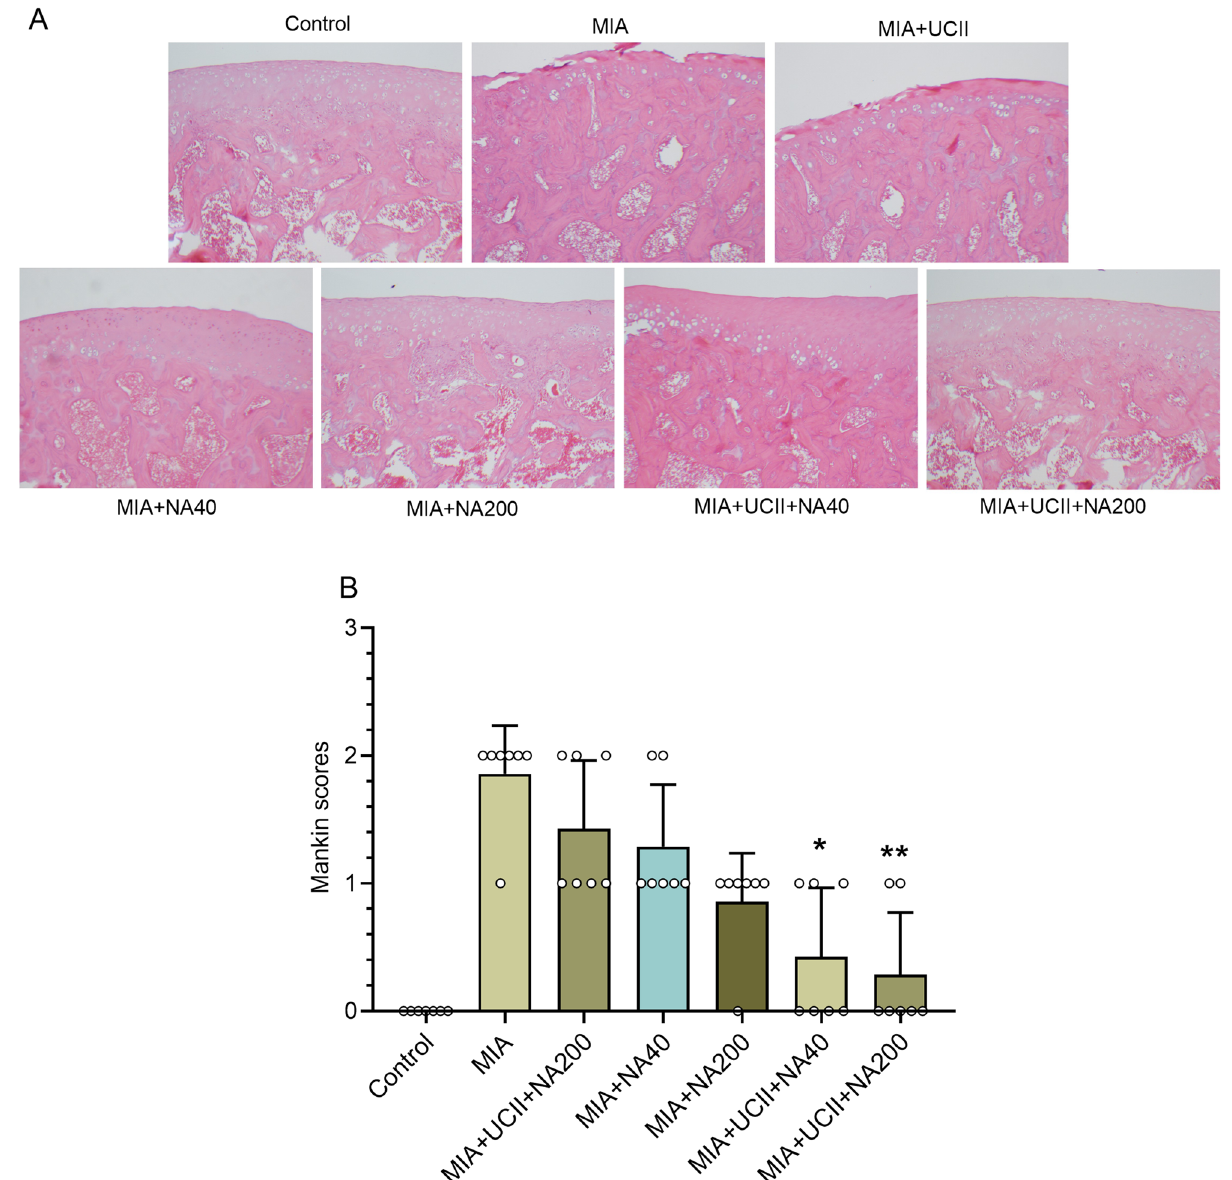
Figure 4. Effects of niacinamide (NA) and undenatured type II collagen (UCII) supplementation on histopathology of the knee joint in monosodium iodoacetate (MIA)-induced osteoarthritis in rats. Representative histopathologic images of hematoxylin–eosin (A) obtained at the end of the experiment are shown. Mean values of Mankin scores are demonstrated with ± standard deviations (B) . Asterisks above the groups indicate statistical differences (Kruskal–Wallis followed by Mann–Whitney U; * p < 0.05; ** p < 0.01; compared as MIA group). Control as a non-supplemental group with no osteoarthritis-induced rats, MIA as a non-supplemental group with monosodium iodoacetate (MIA)-induced knee osteoarthritis, MIA + UCII as MIA group gavage-fed a supplemental UCII at 4 mg/kg, MIA + NA40 as MIA group gavage-fed supplemental niacinamide (NA) at 40 mg/kg, MIA + NA200 as MIA group gavage-fed a supplemental NA at 200 mg/kg, MIA + UCII + NA40 as MIA group gavage-fed both supplemental UCII at 4 mg/kg and NA at 40 mg/kg and MIA + UCII + NA200 as MIA group gavage-fed both supplemental UCII at 4 mg/kg and NA at 200 mg/kg. Oral gavage delivery of supplements was applied from d7 to